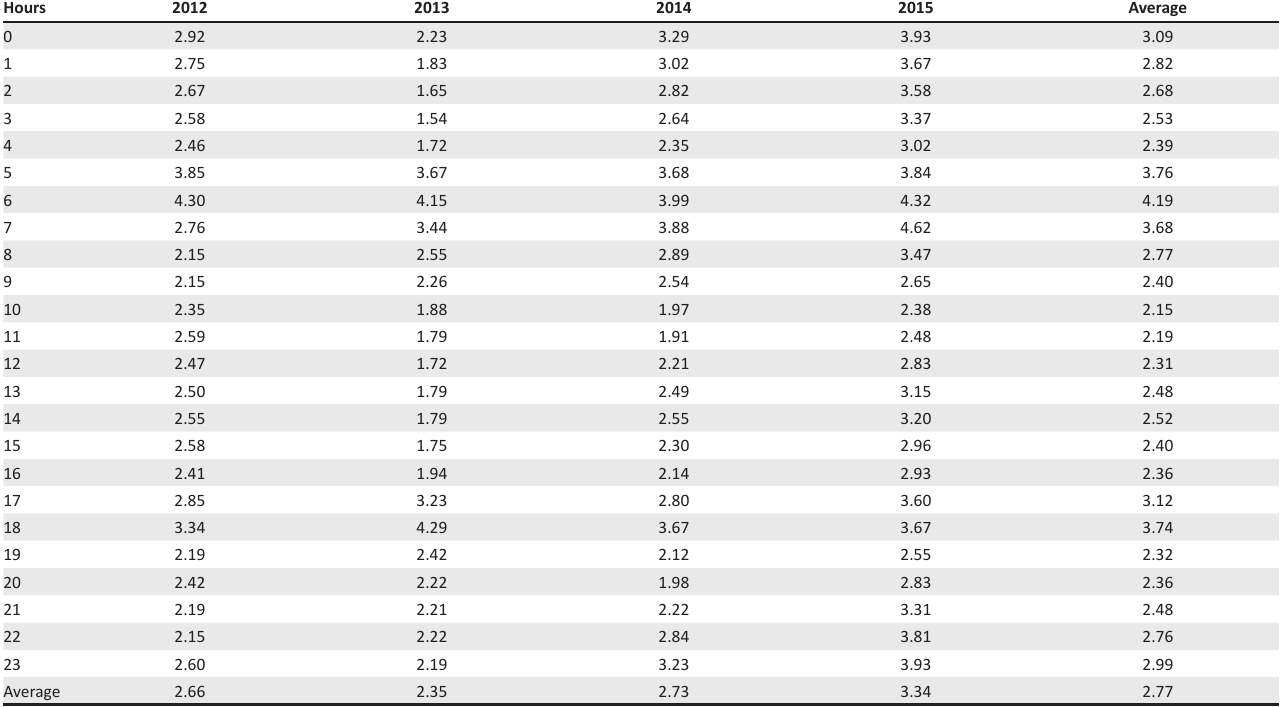
TABLE 2-A1: Mean absolute percentage error – Forecasts at the 50th percentile.